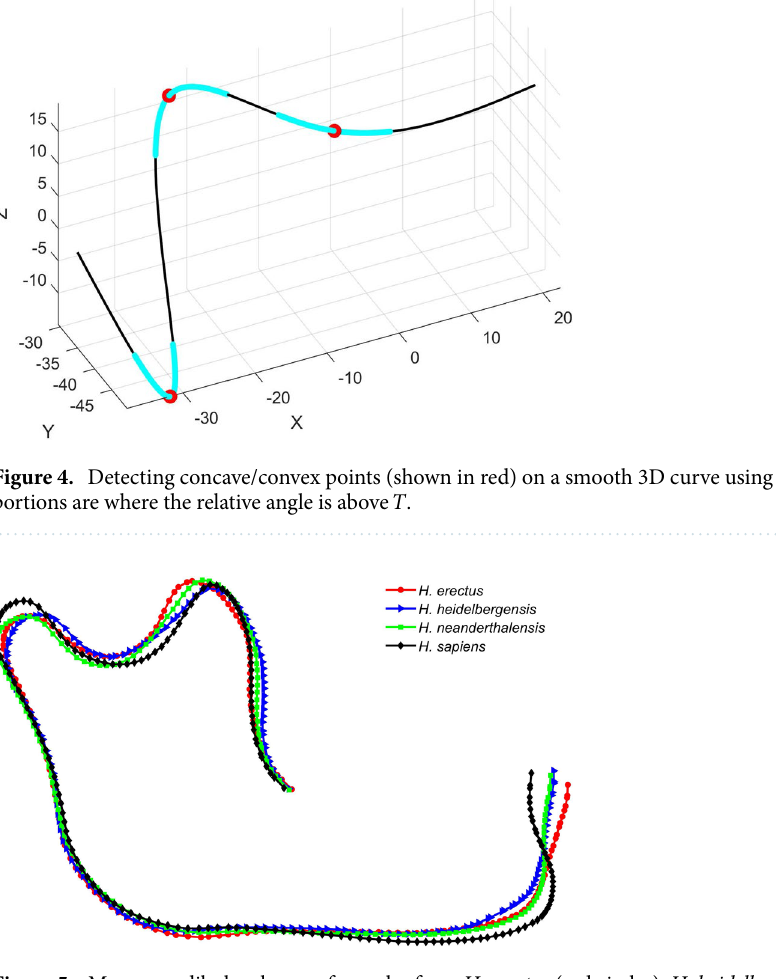
Figure 5. Mean mandibular shapes of samples from H. erectus (red circles), H. heidelbergensis (blue triangles), H. neanderthalensis (green squares), and H. sapiens (black